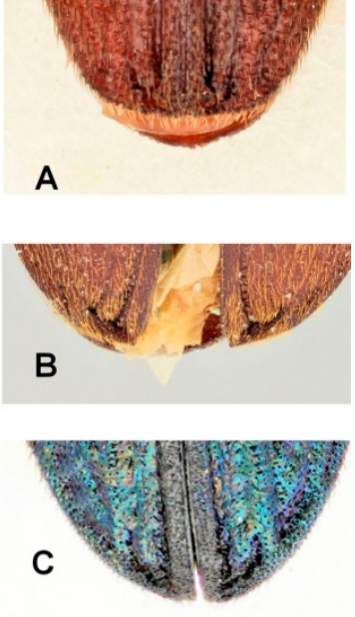
Figure 1. Eucnemidae. Elytral apices with specialized pores on the first and outmost striae apically. ( A ). Euryptychus sp. ( B ). Phaenocerus subclavatus Bonvouloir. ( C ). Calyptocerus irdis Otto.